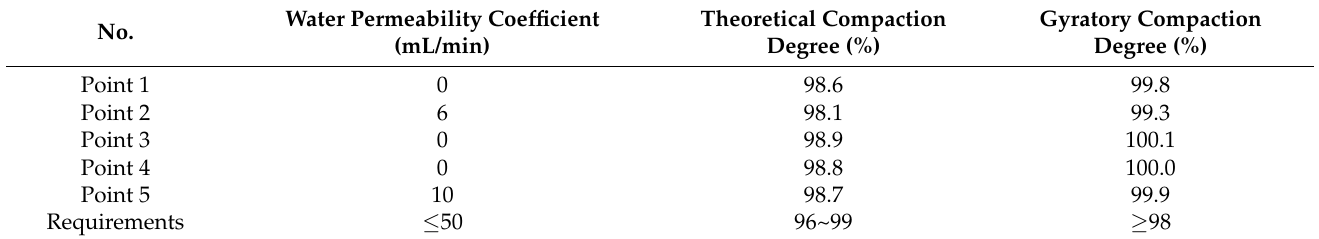
Table 12. Results of high-modulus asphalt pavement.